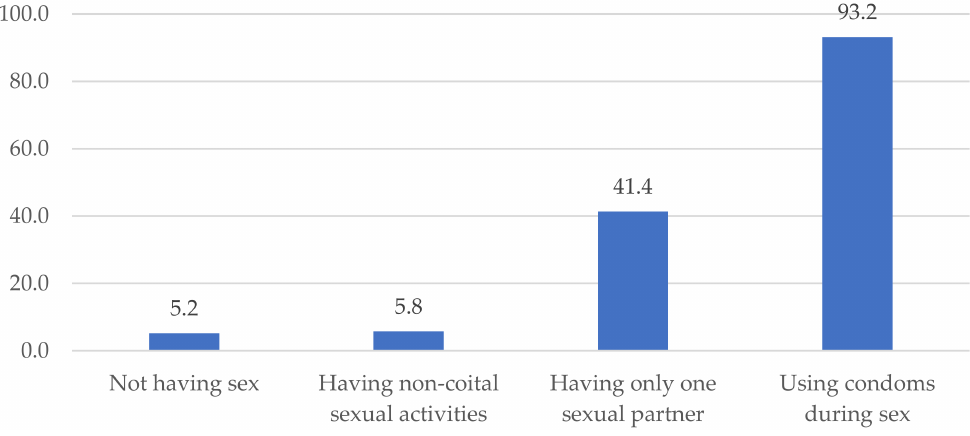
Figure 2. Safe sex behavior